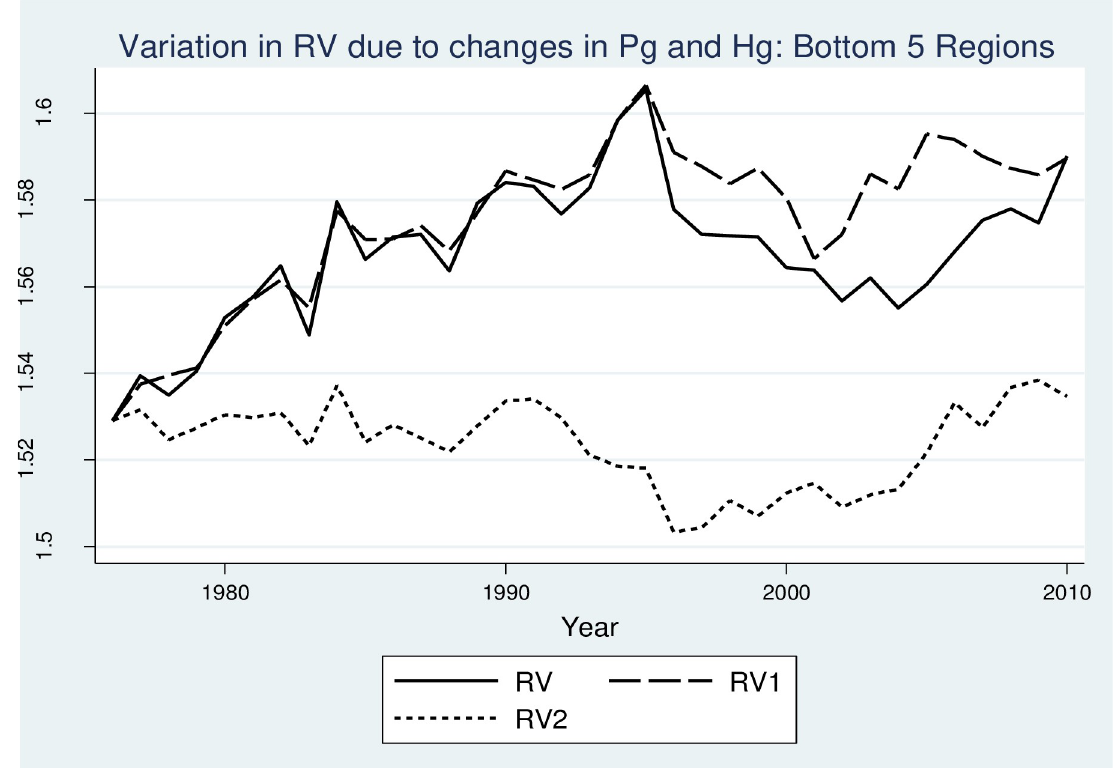
Fig 9. Relative importance of Pg and Hg in the growth of RV over time: Bottom 5 regions. Notes: RV1: Related variety measured by keeping Pg constant at the values at 1976. RV2: Related variety measured by keeping Hg constant at the values at 1976.